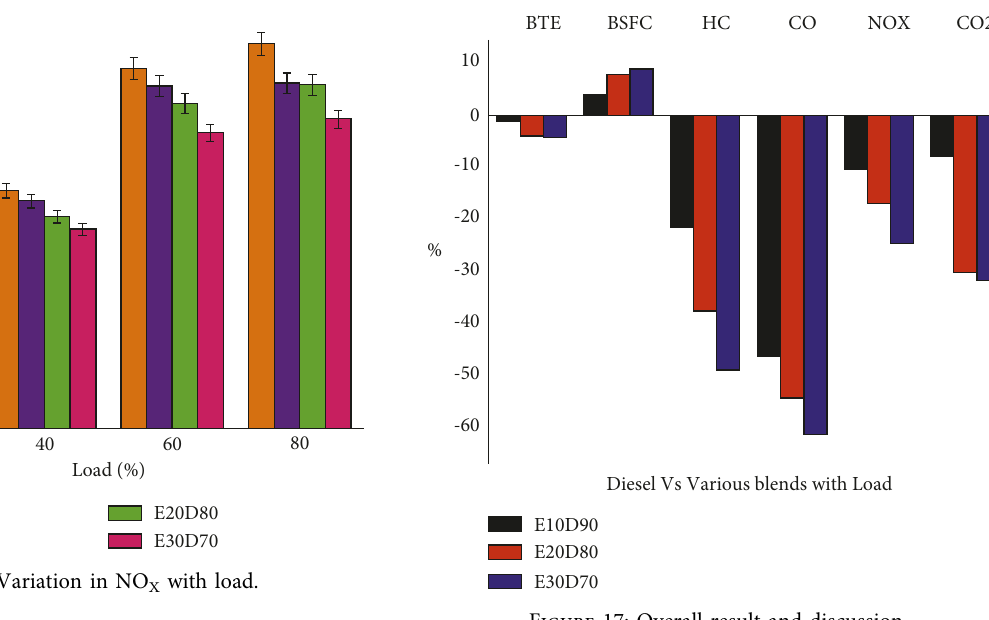
Figure 17: Overall result and discussion.